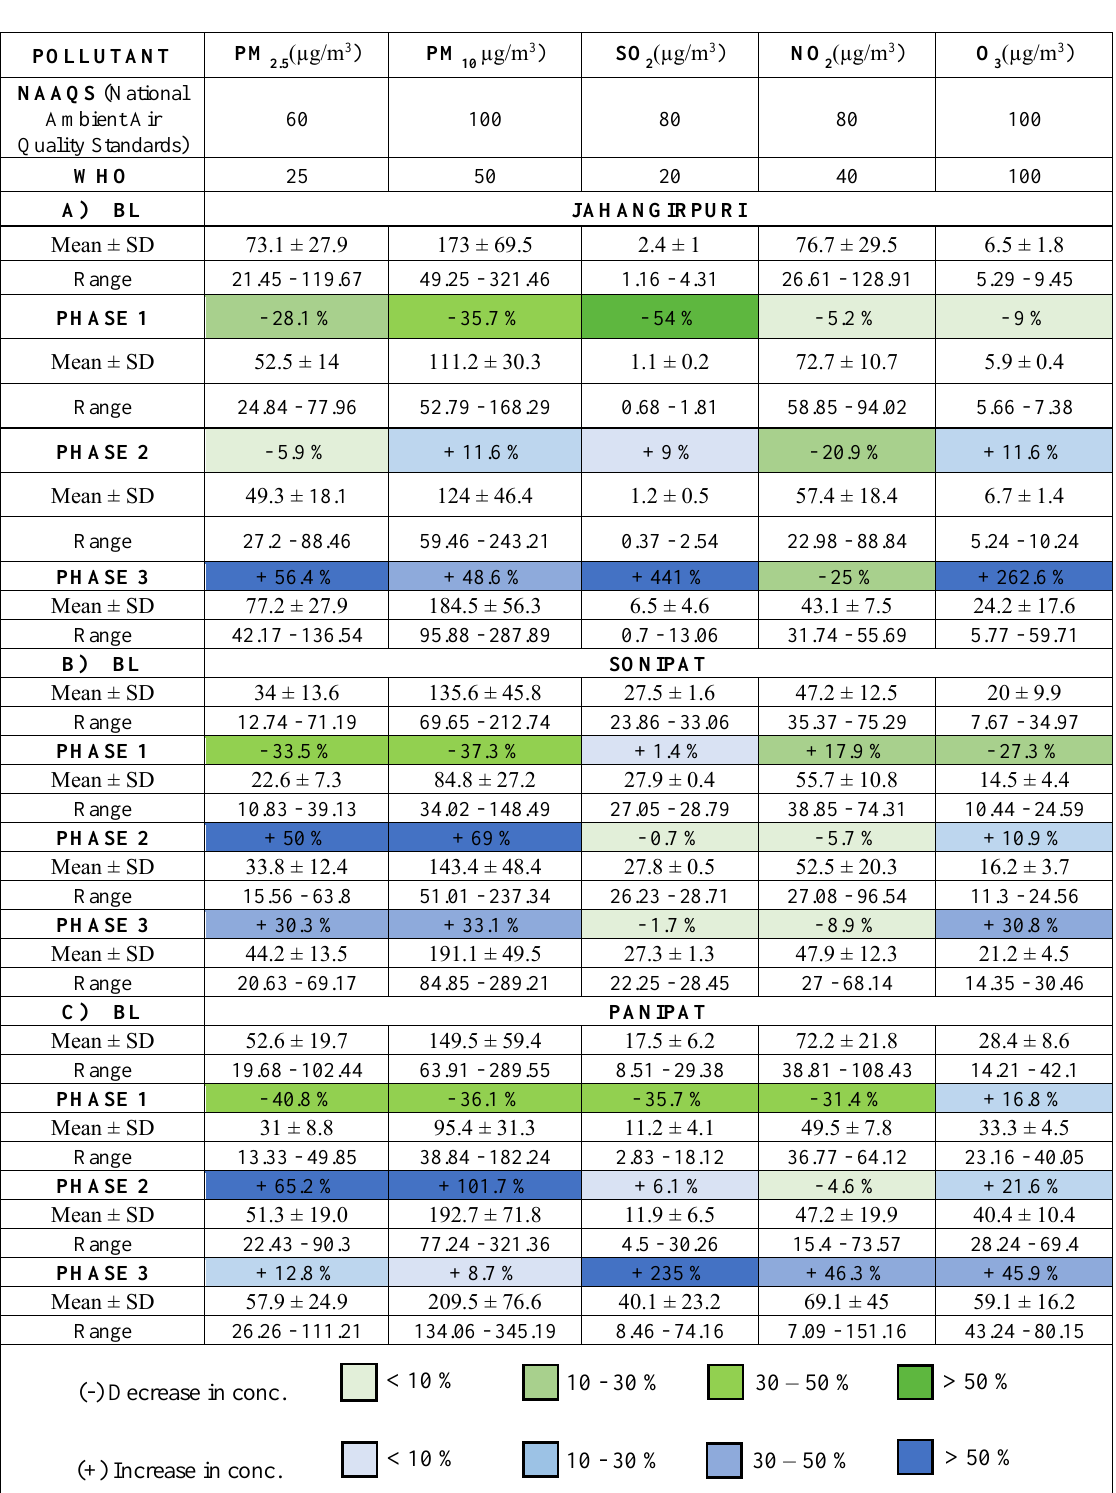
Table 1. Average concentrations of pollutants at three different sites along national highway 44 in NCR region and percentage change (decrease or increase) in pollutant levels before lockdown and during lockdown